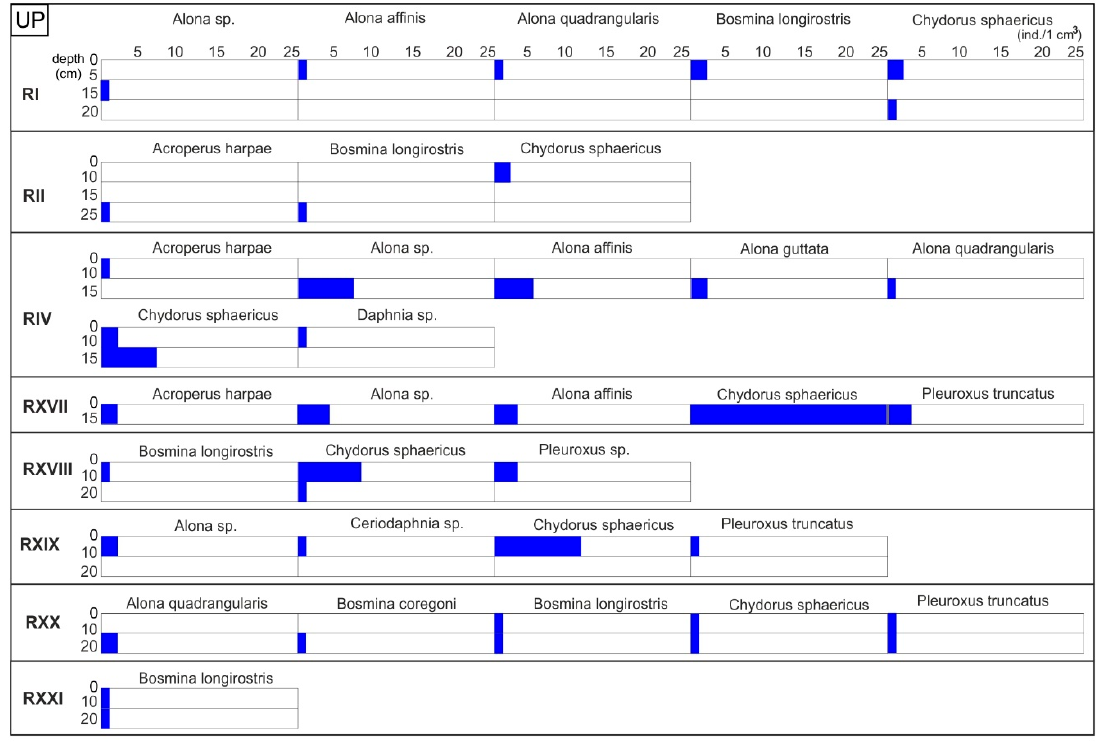
Figure 3. Diagram of the absolute number of Cladocera individuals in 1 cm 3 of sediment from subsidence pond formed after the closure of the mine (UP).